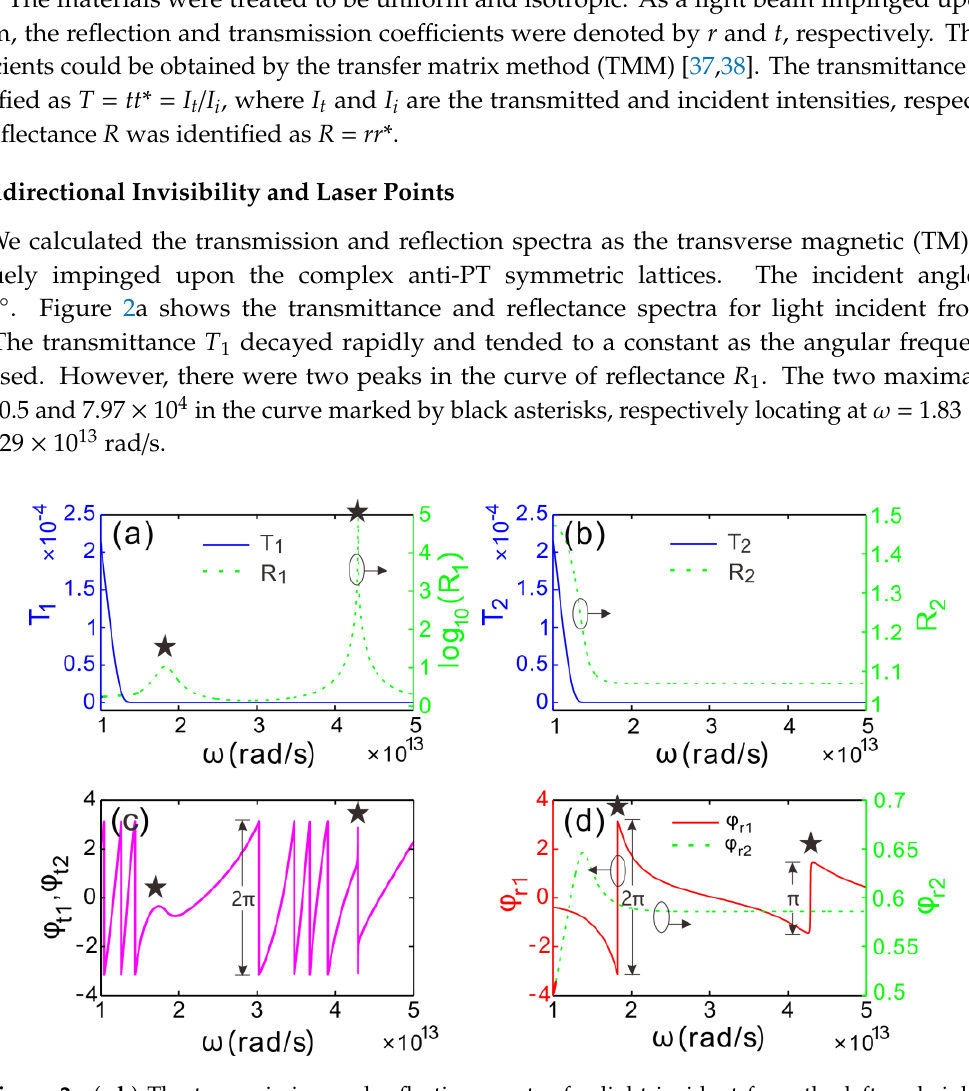
Figure 2. ( a , b ) The transmission and reflection spectra for light incident from the left and right, respectively. ( c , d ) The phases of transmission coefficient and reflection coefficient for the complex anti-PT symmetric PCs, respectively.